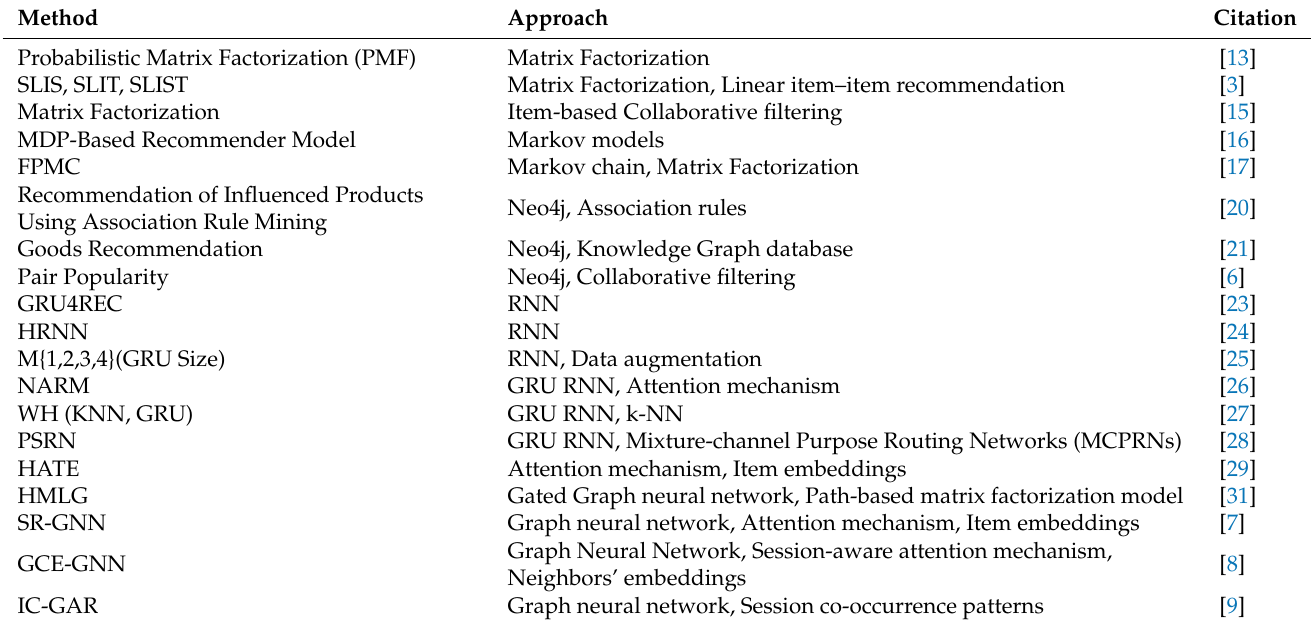
Table 1. Summary of reviewed